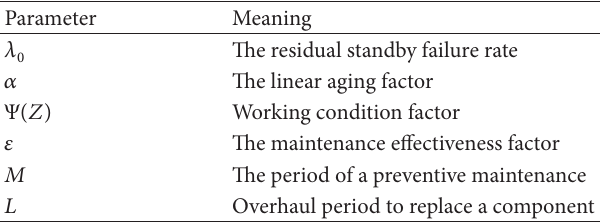
Table 1: Meanings of the parameters used in